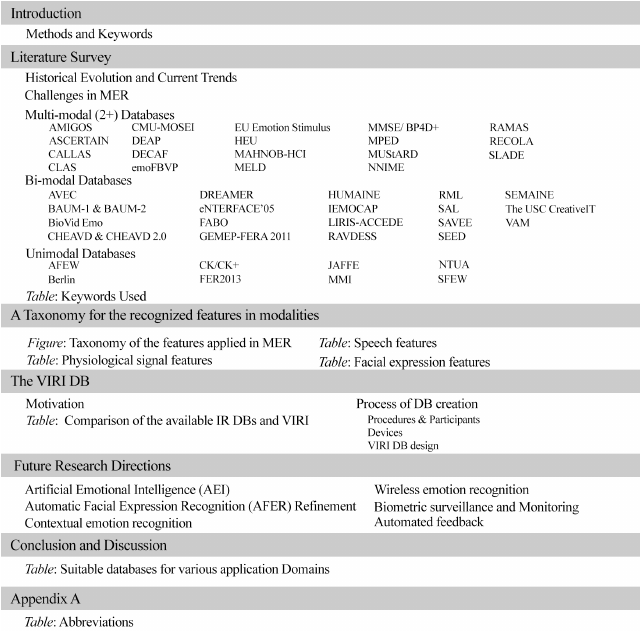
Figure 1. Review paper